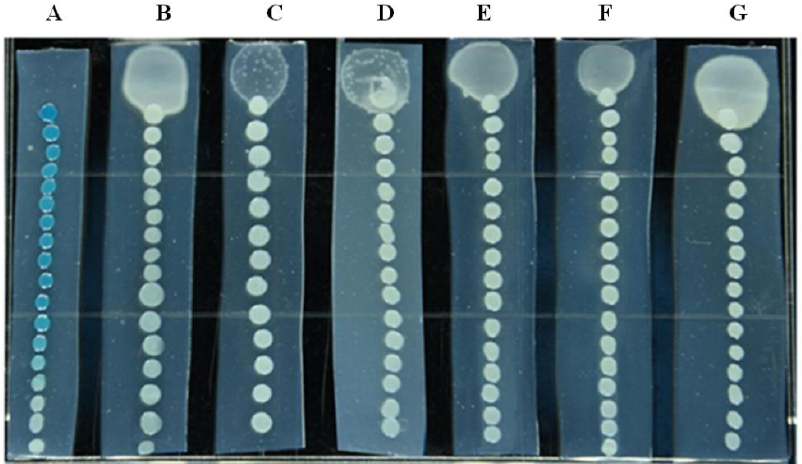
Figure 1. Degradation activity of N -acyl-homoserine lactone (AHL) by strain XN-10. The degradation activity of AHL by strain XN-10 was tested using various concentrations of N -(3-oxohexanoyl)-L-homoserine lactone (OHHL) (i.e., 5, 10, 15, 20, 25, and 30 µ mol · L − 1 ) ( B – G ) compared to a blank control ( A ) only containing 30 µ mol · L − 1 of OHHL. The residual content of OHHL in the sample was determined according to the distance of the report strain on the agar strip from the top to blue. The columns containing the various concentrations of OHHL did not turn blue, indicating that the OHHL was completely degraded by strain XN-10.